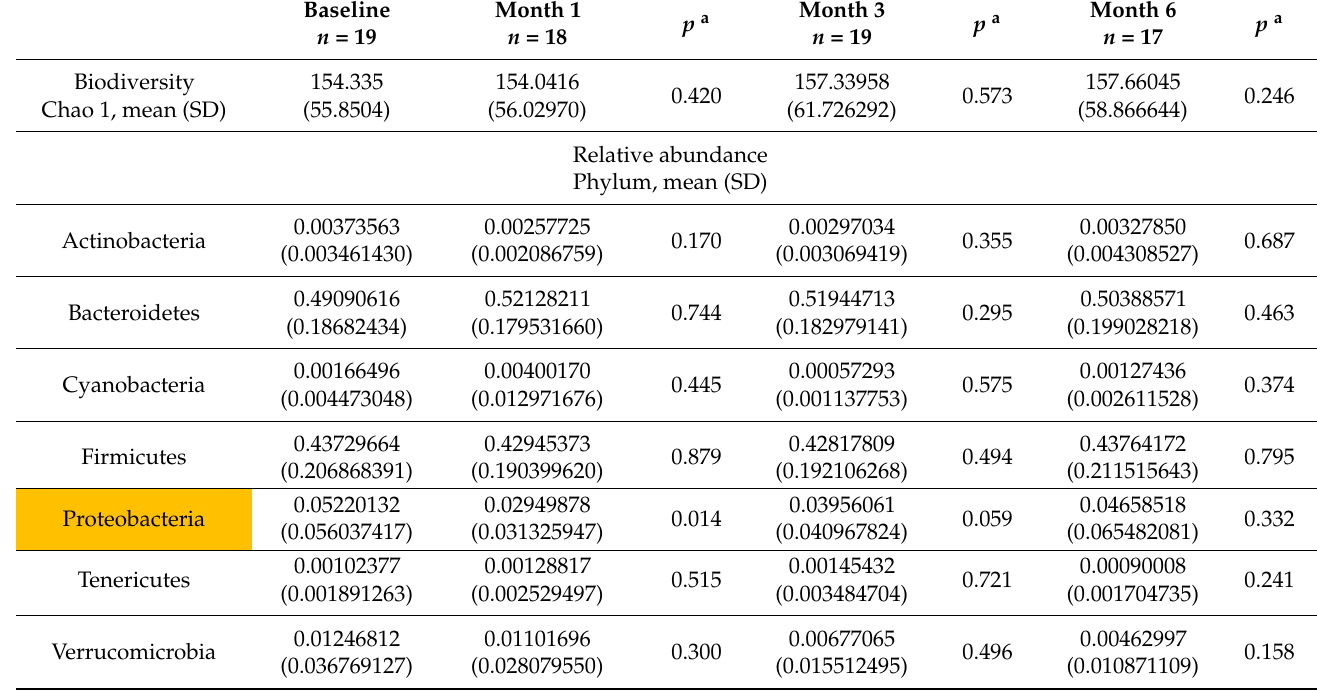
Figure 1. Relative abundance at phyla level for each patient (column) at baseline. Table 2. Biodiversity and relative abundance of the gut microbiota bacteria by phylum, family, and genus during the treatment with DMF. The α biodiversity is expressed as the Chao 1 index. We reported all the analyzed phyla and the families and genera with significant modification in relative abundance during DMF treatment compared to baseline values. The taxa that increased at any time point during DMF treatment are shown in green and those that reduced in orange.